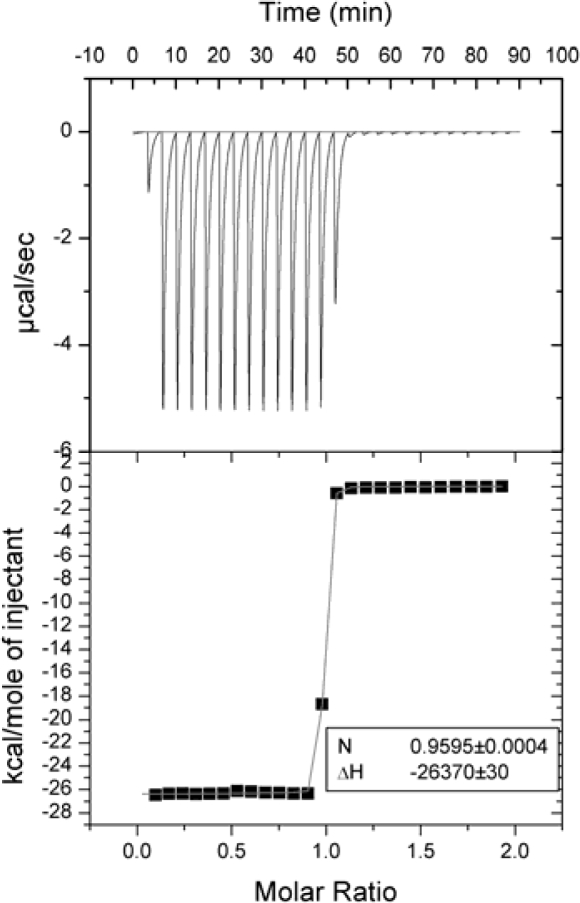
Titration of 0.1 mM NaI with 1.0 mM AgNO3 at 25 °C using VP-ITC (Microcal, Inc.) microcalorimeter.